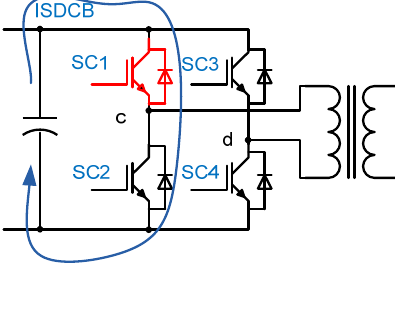
Figure 9. Schematic diagrams of isolation stage for fault D1 (IGBT SC1 short-circuit).